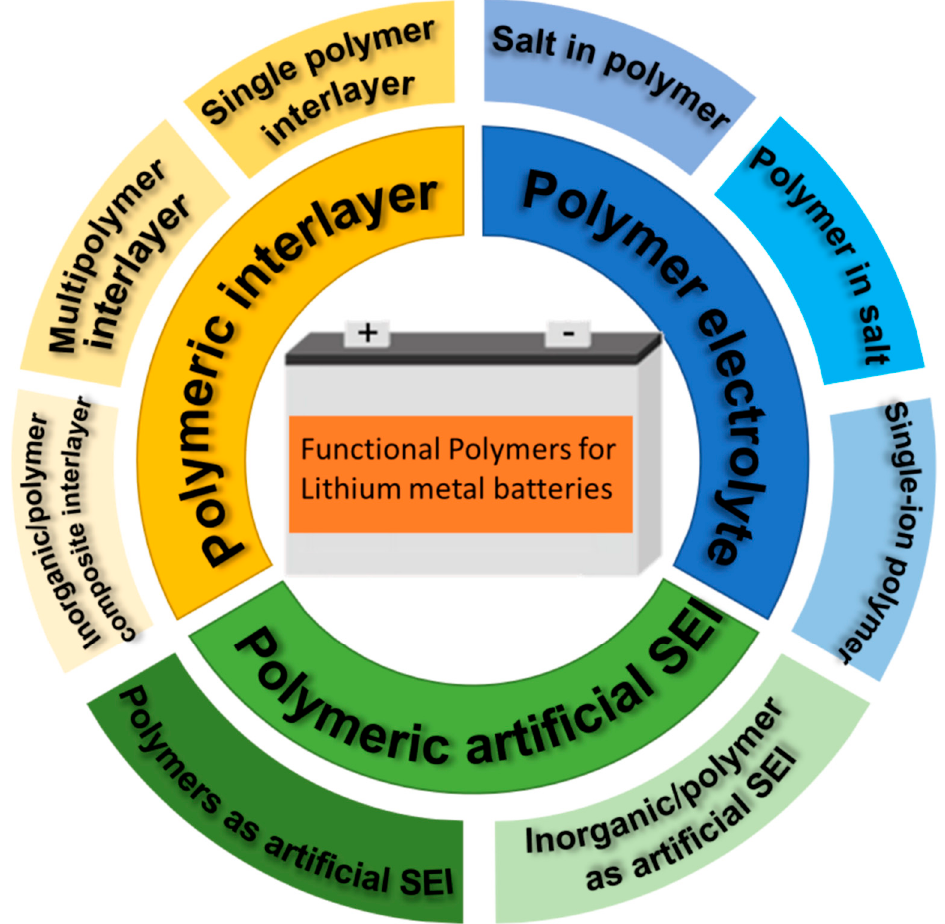
Figure 1. Classification of functional polymer materials in LMBs.